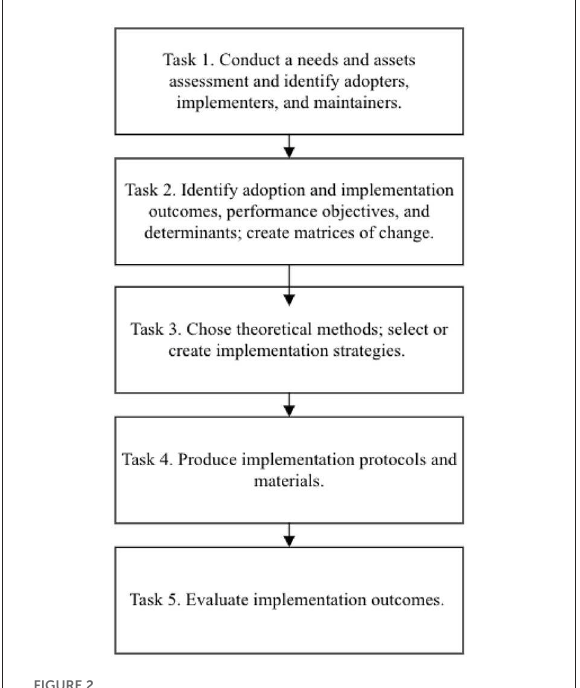
FIGURE2 Implementation mapping process from Fernandez et al.